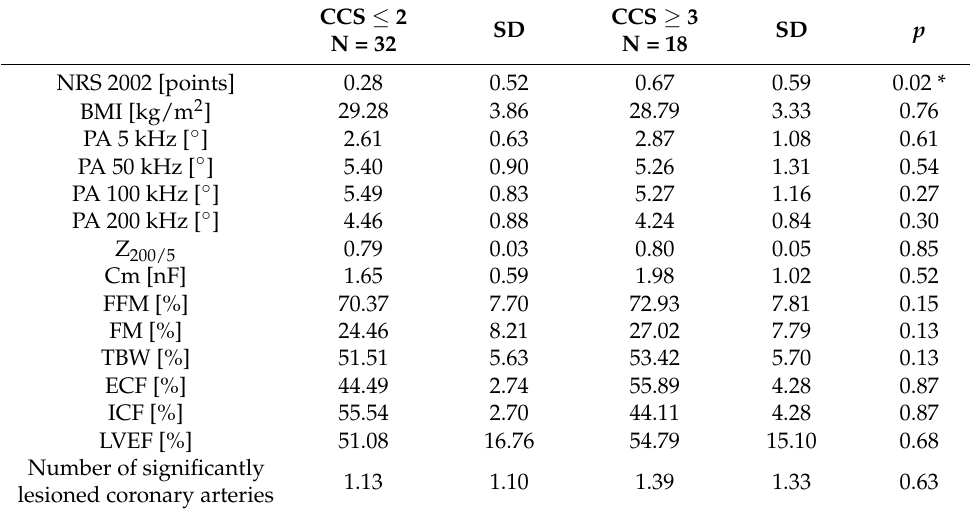
Table 2. Comparison of nutritional status and imaging parameters between CAD with CCS class ≤ 2 or ≥